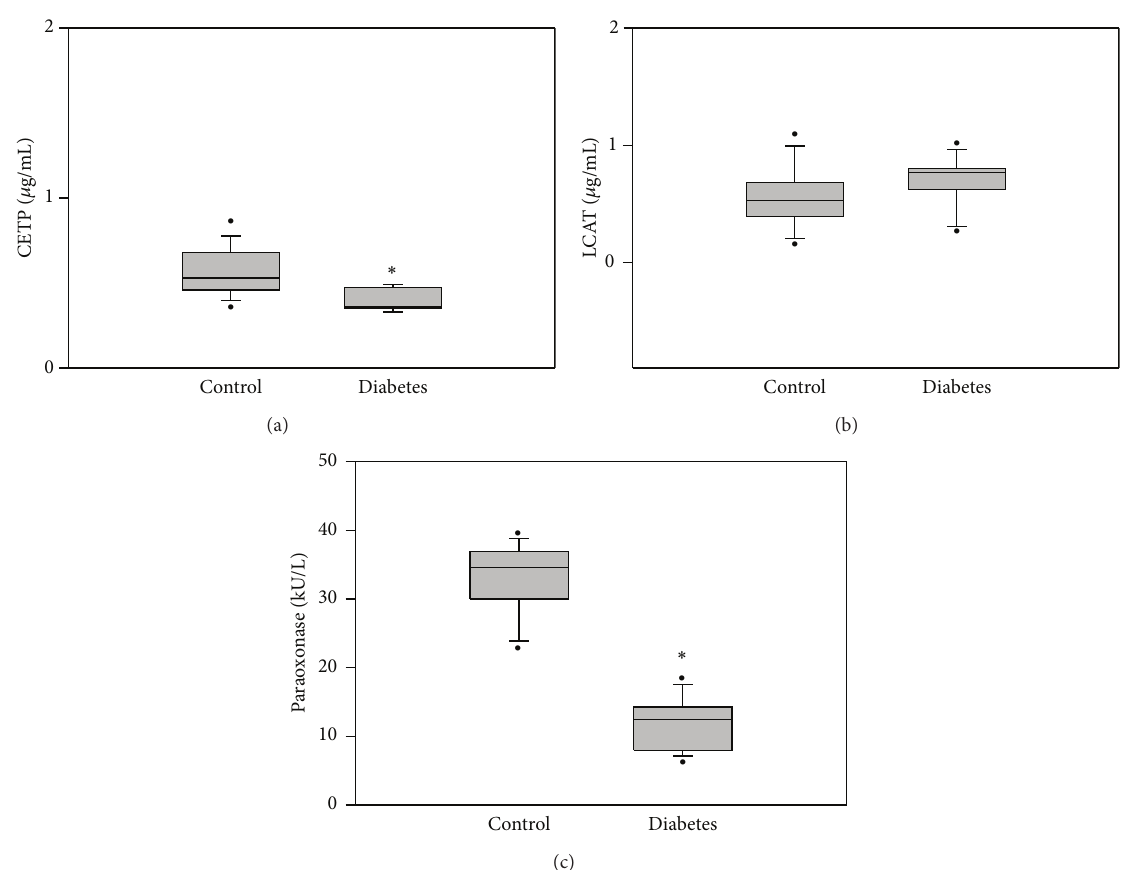
Figure 2: (a) Box plot graph data of plasma cholesteryl ester transfer protein (CETP) measured in control ( 𝑛 = 15 ) and diabetic ( 𝑛 = 5 ) guinea pigs. Statistical analysis was by Student’s t -test, ∗ 𝑃 = 0.037 . (b) Box plot graph data of lecithin-cholesterol acyltransferase (LCAT) measured in control ( 𝑛 = 15 ) and diabetic ( 𝑛 = 5 ) guinea pigs. (c) Paraoxonase (PON1) activity measured in control ( 𝑛 = 15 ) and diabetic ( 𝑛 = 5 ) guinea pigs. Statistical analysis was by Student’s t -test, ∗ 𝑃 < 0.001 .